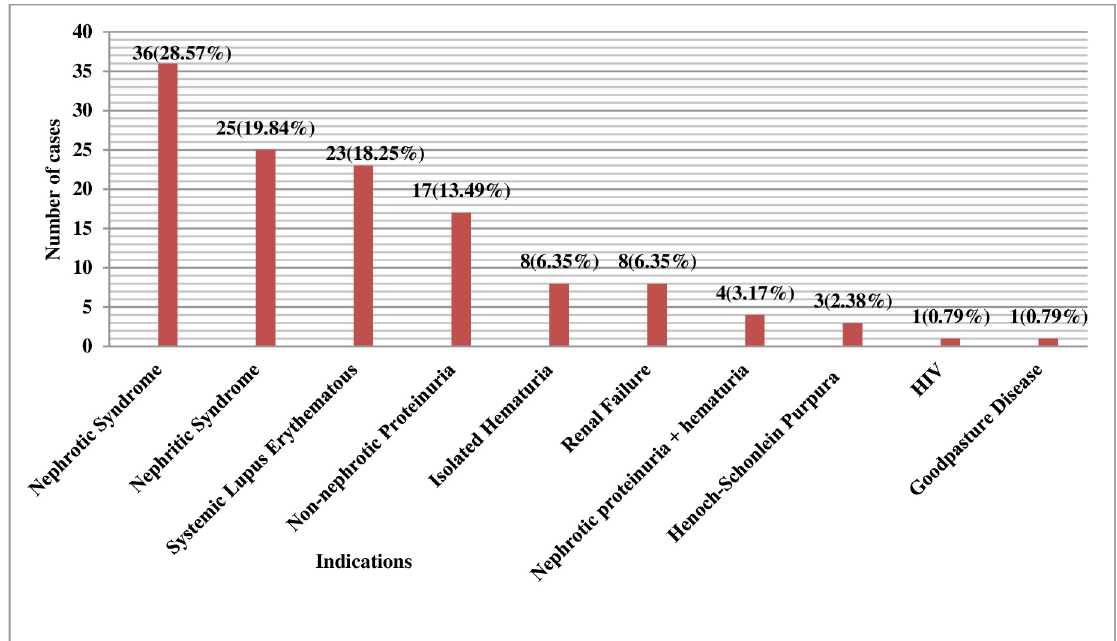
Fig 2. Clinical indications of renal biopsy in children (N =